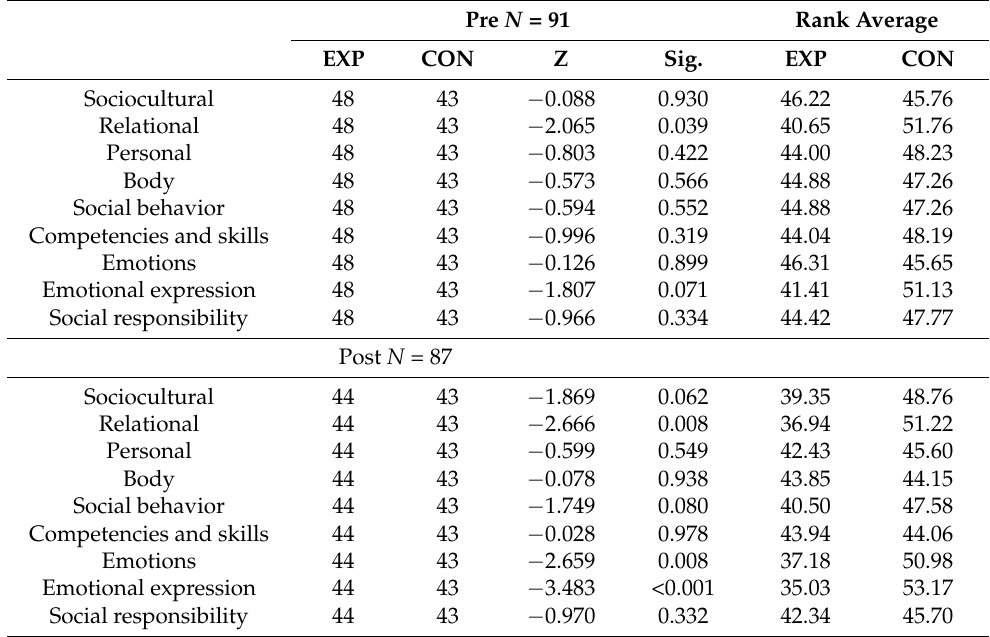
Table 3. Differences between the control and experimental groups on the initial and final measures for the gender attitude variables measured.